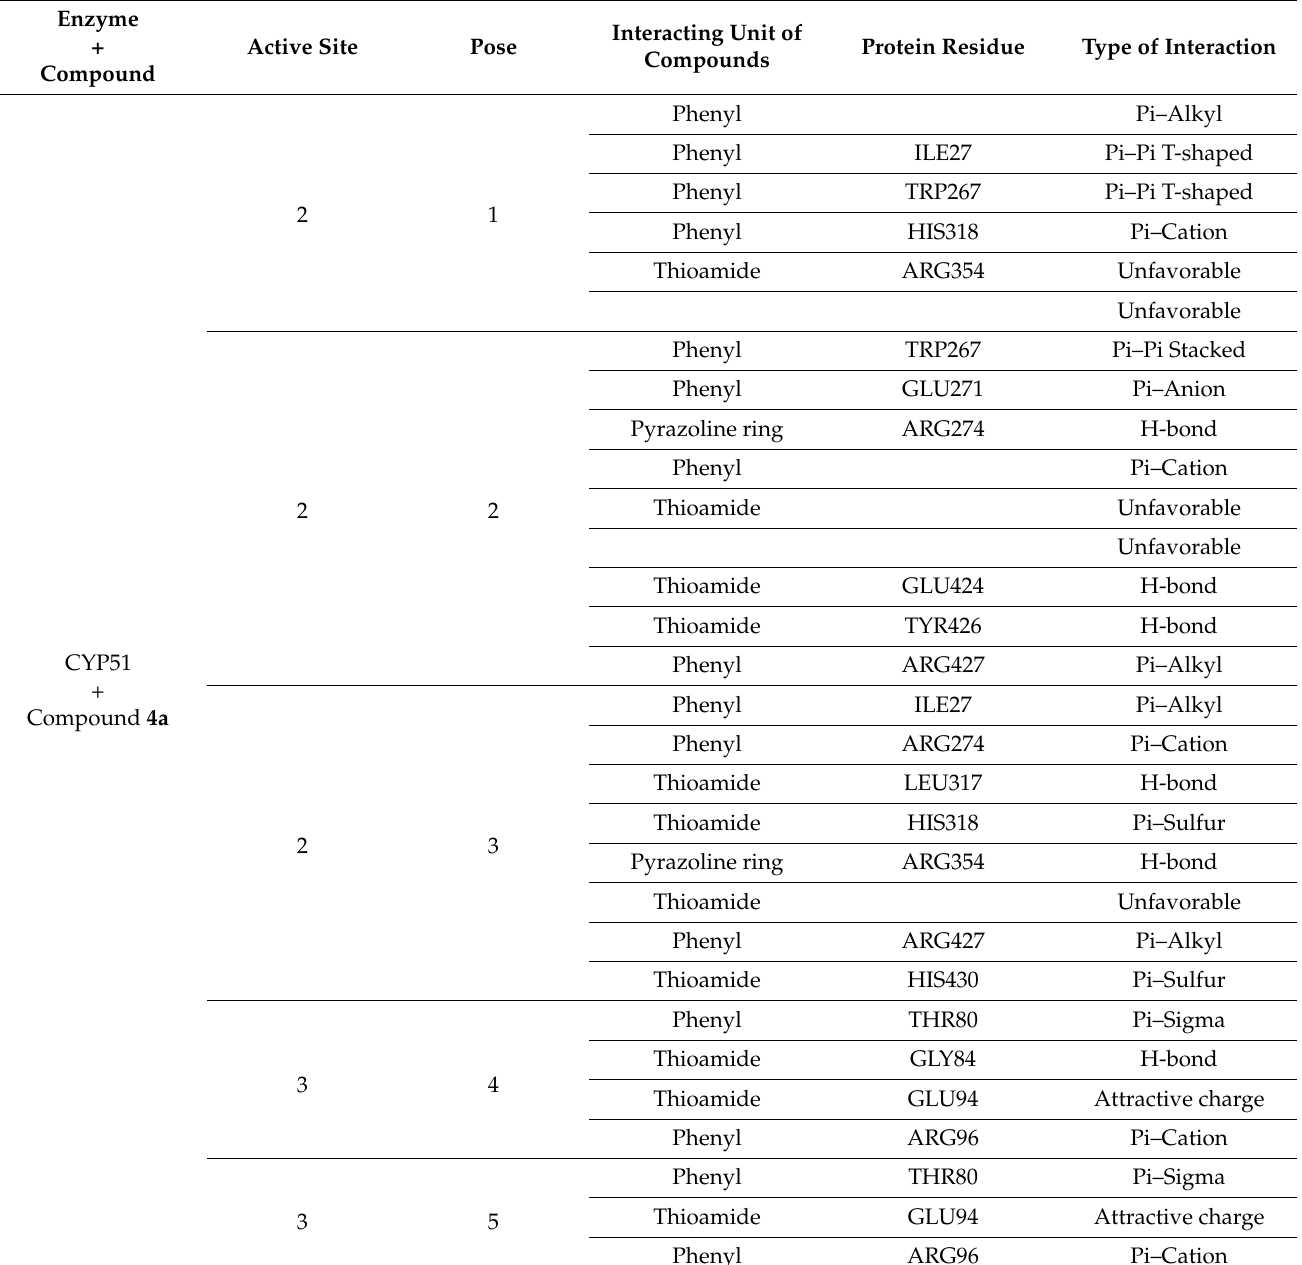
Table 3. Binding interactions between compound 4a with CYP51 (poses 1 to